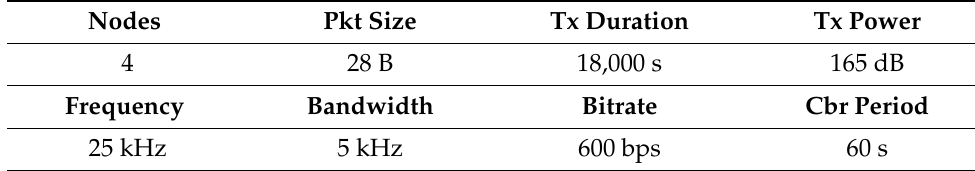
Table 4. Simulation